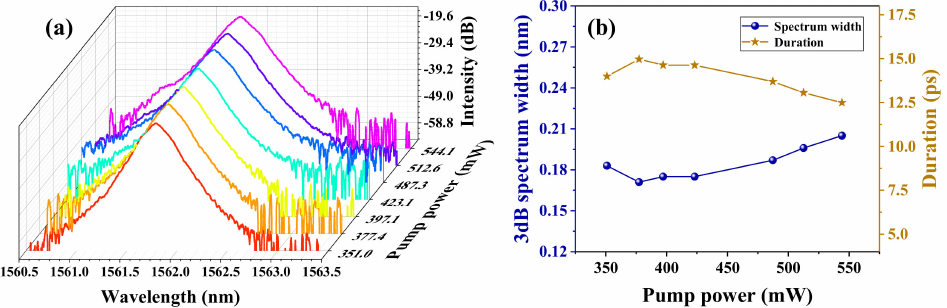
Figure 7. ( a ) The output optical spectrum at di ff erent pump powers. ( b ) The 3 dB spectrum width and the theoretical duration of the single mode-locking pulse versus the pump